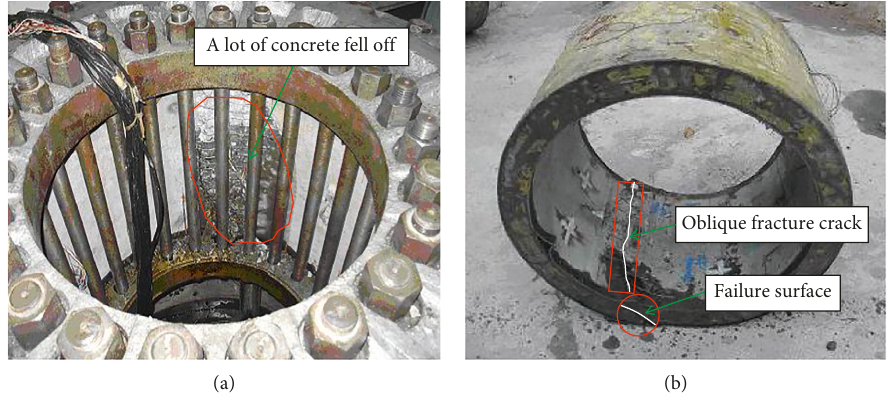
Figure 10: Shaft lining model failure